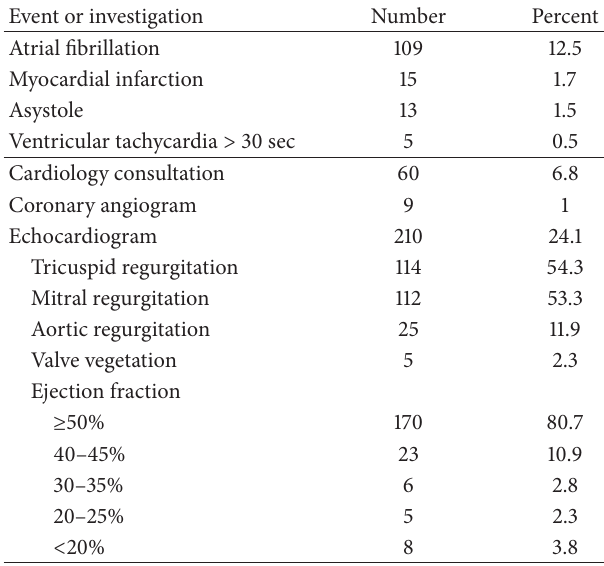
Table 6: Cardiac events and investigations 871 patients with